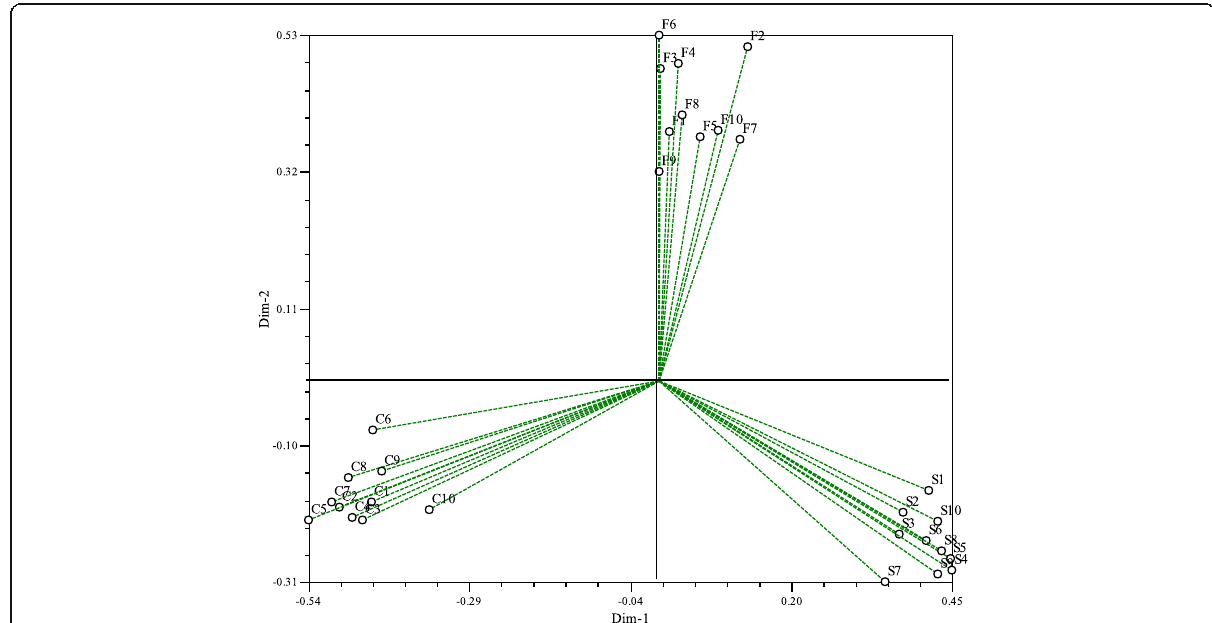
Fig. 8 Distribution of 30 culms of three different growth forms of Dendrocalamus strictus by 2-dimensional principal coordinate analysis. PCo axis 1 and PCo axis 2 account for 21.9 and 15.9% of the variations,